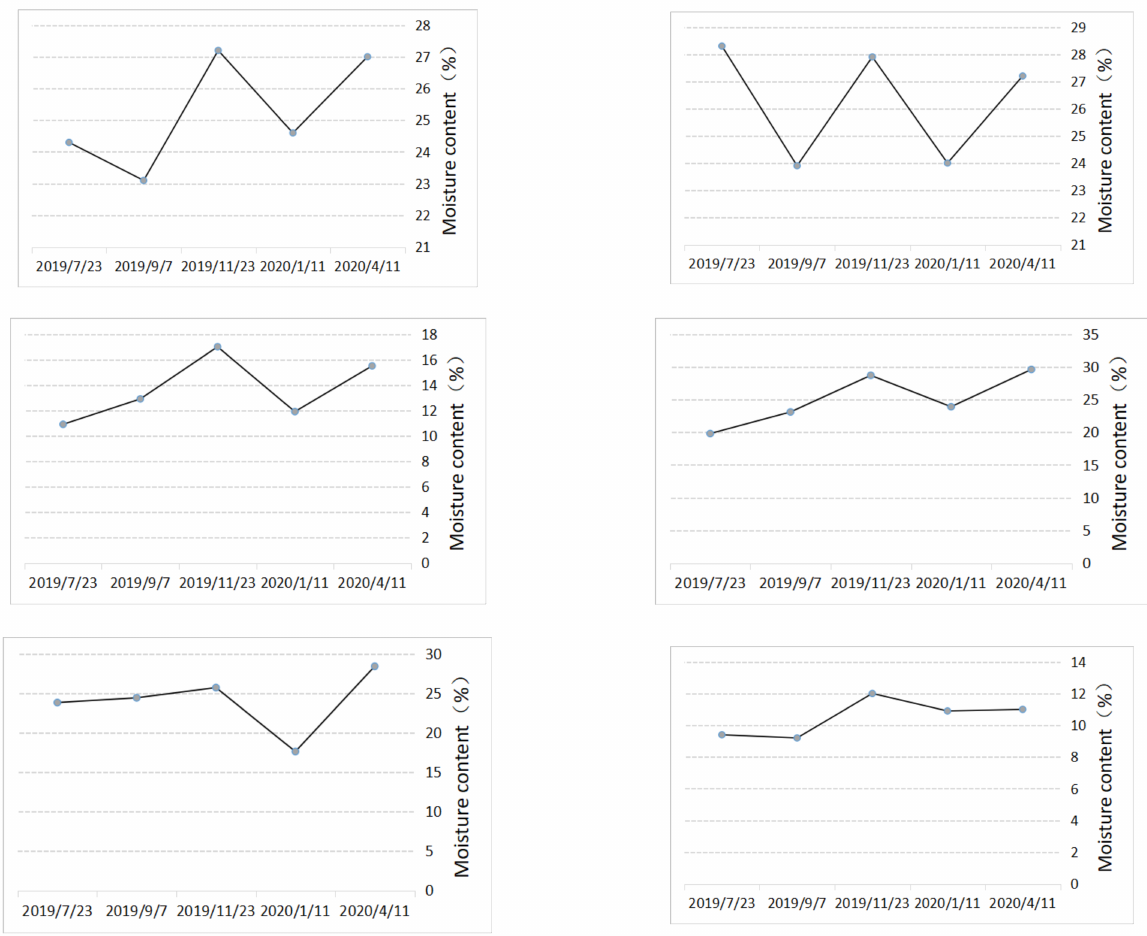
Figure 9. The water content of each measuring